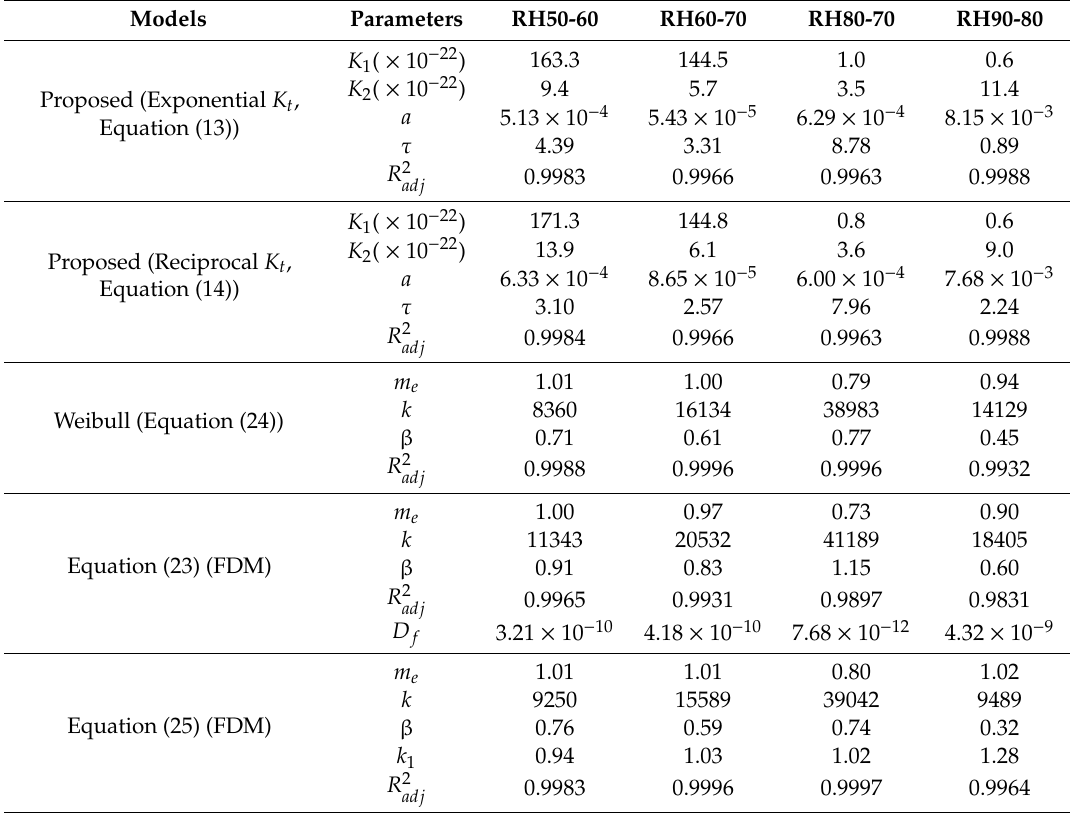
Table 1. Fitted parameters for compared